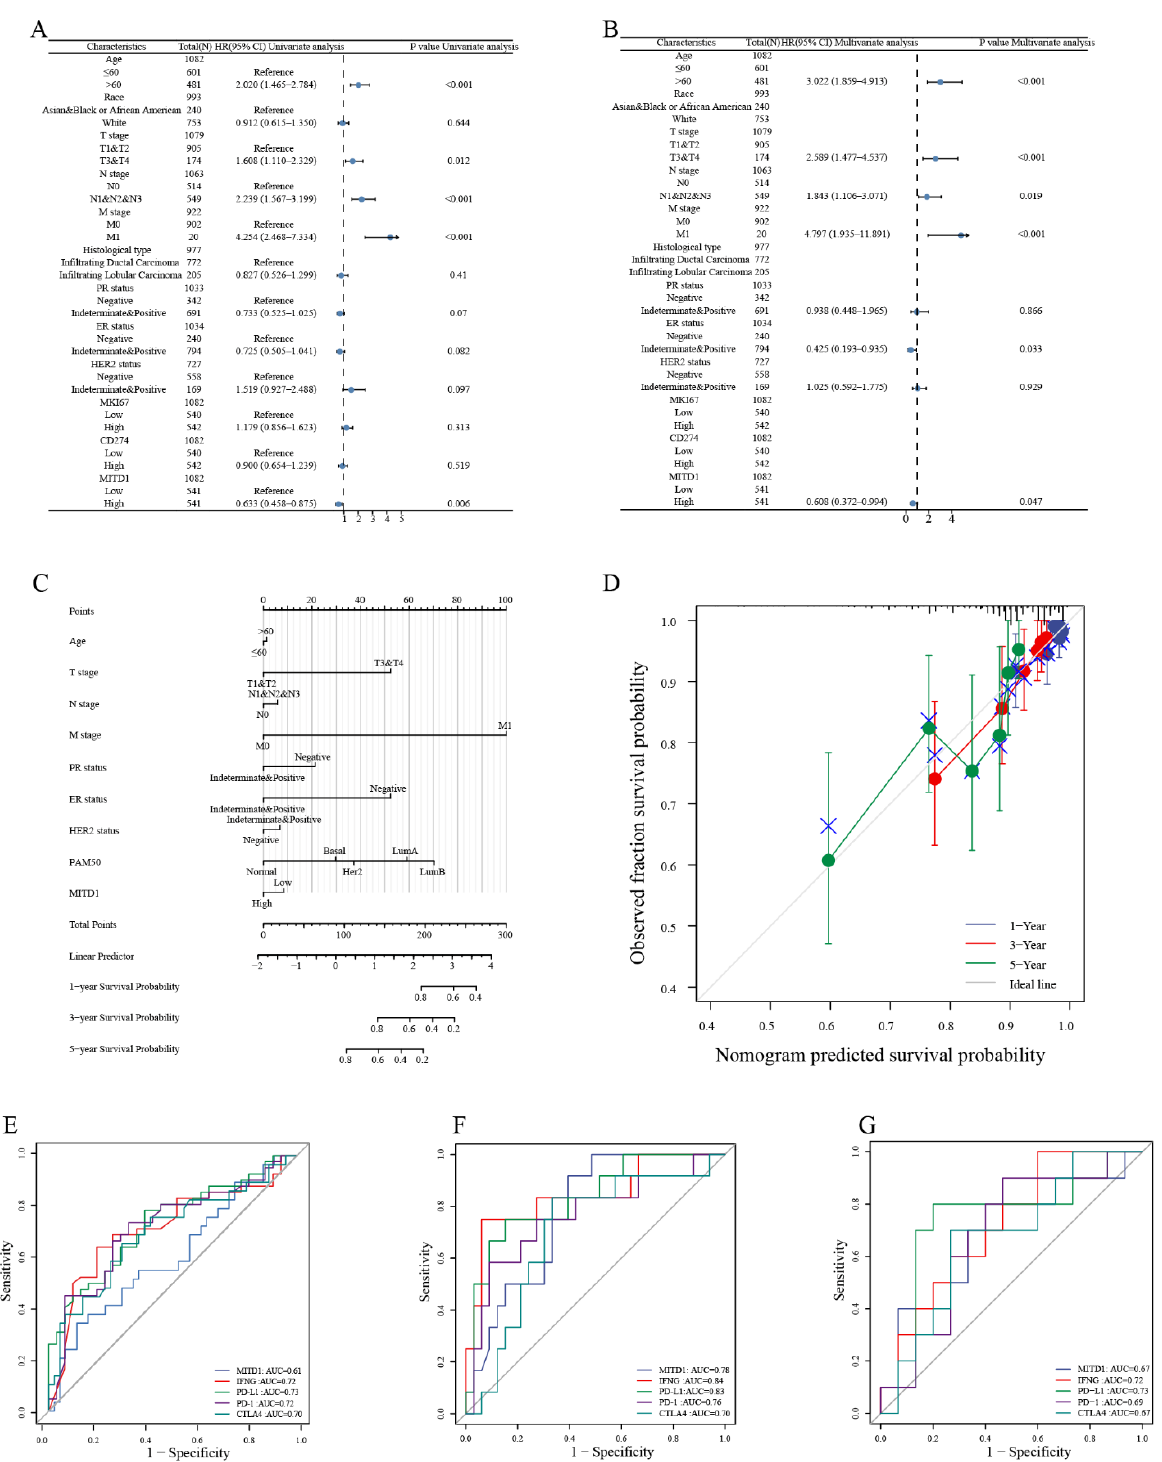
Figure 8. Diagnostic and predictive value of MITD1. ( A ) Univariate Cox regression analysis of MITD1. ( B ) Multivariate Cox regression analysis of MITD1. ( C ) A nomogram for predicting the probability of 1-, 3-, and 5-year PFI for patients with BRCA. ( D ) Calibration plots of the nomogram for predicting the probability of 1-, 3-, and 5-year PFI for patients with BRCA. ( E – G ) The ROC curves and AUC values of MITD1 and four other biomarkers for predicting immunotherapy response in PRJEB23709, PRJEB25780 and GSE100797